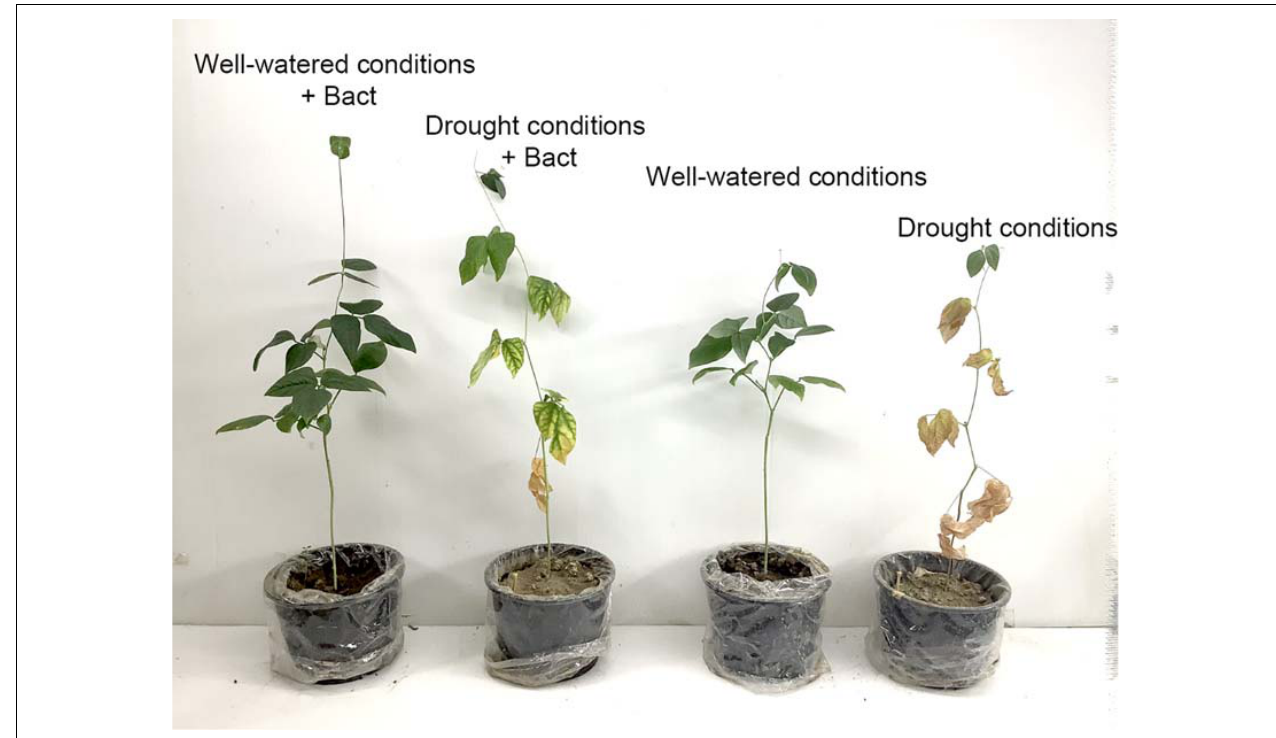
FIGURE 9 | Growth of cowpea ( V. unguiculata ) in well-watered and drought conditions with/without B. aryabhattai MoB09 in day 45 after sowing.